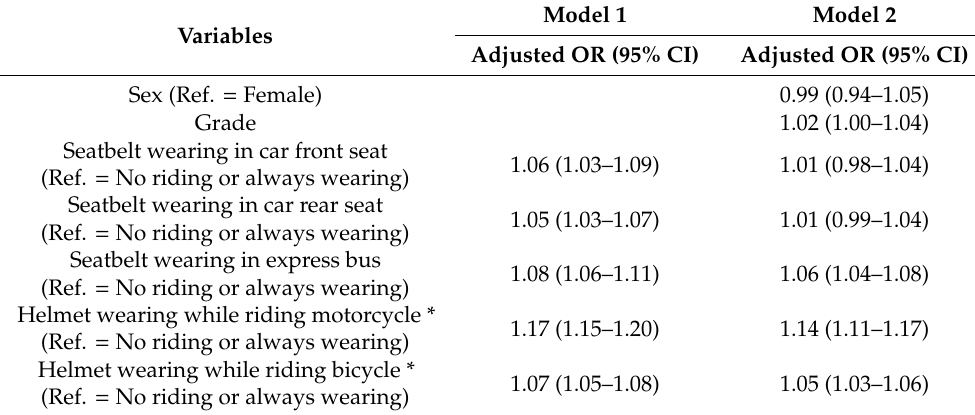
Table 6. The adjusted association of the tooth fracture experience in the past 12 months with variables related to seatbelt or helmet usage assessed by two complex-sample multivariable logistic regression